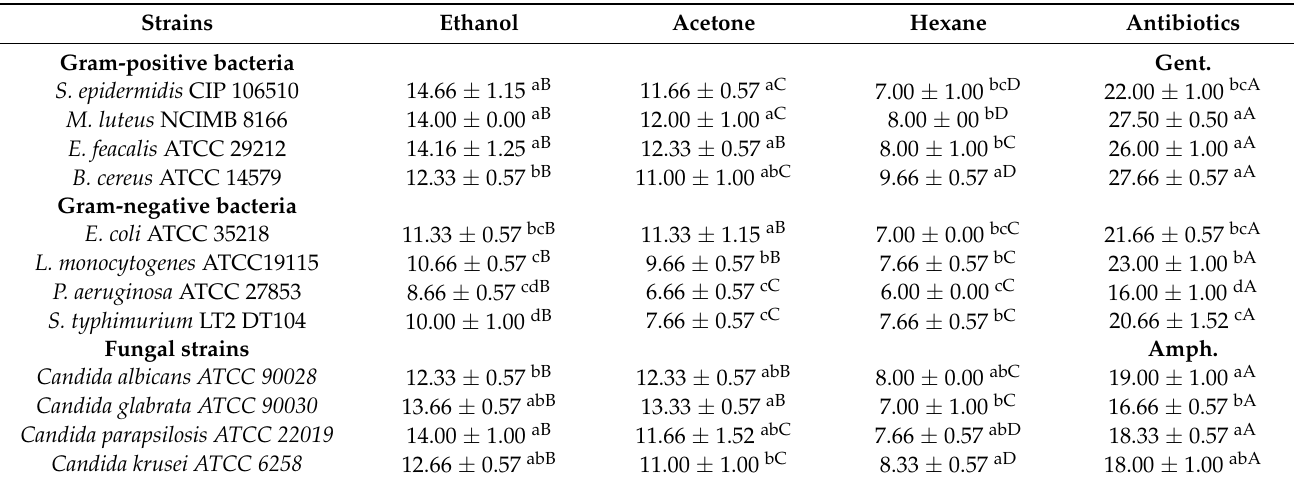
Table 5. Inhibition zones of growth (IZ mm ± SD), showing the qualitative antimicrobial activity of three A. indicum extracts against human pathogenic bacteria compared to standard antibiotics (Gentamycin, Amphotericin